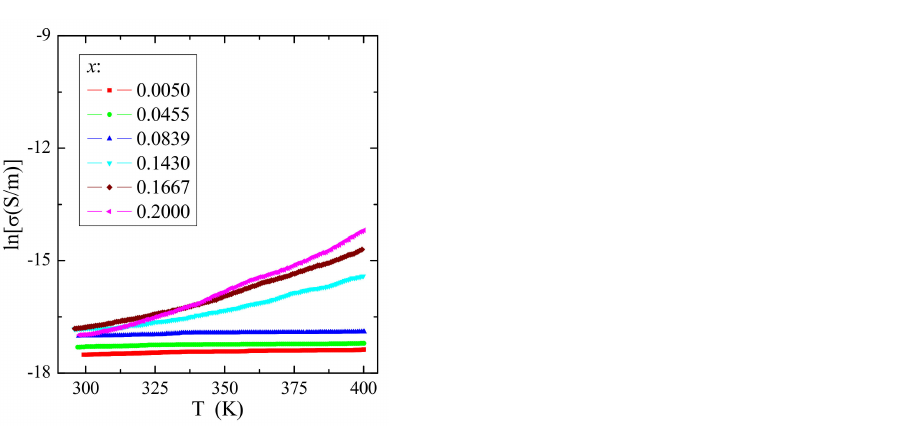
Figure 9. Electrical conductivity (ln σ ) vs. reciprocal temperature 10 3 / T of CCGMWO solid solution.